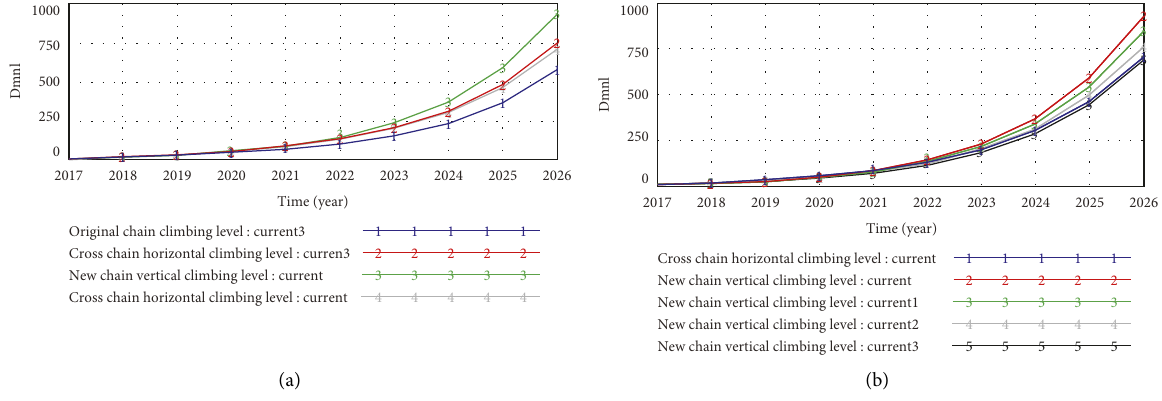
Figure 8: (a) Sensitivity analysis of green development. (b) Sensitivity analysis of green